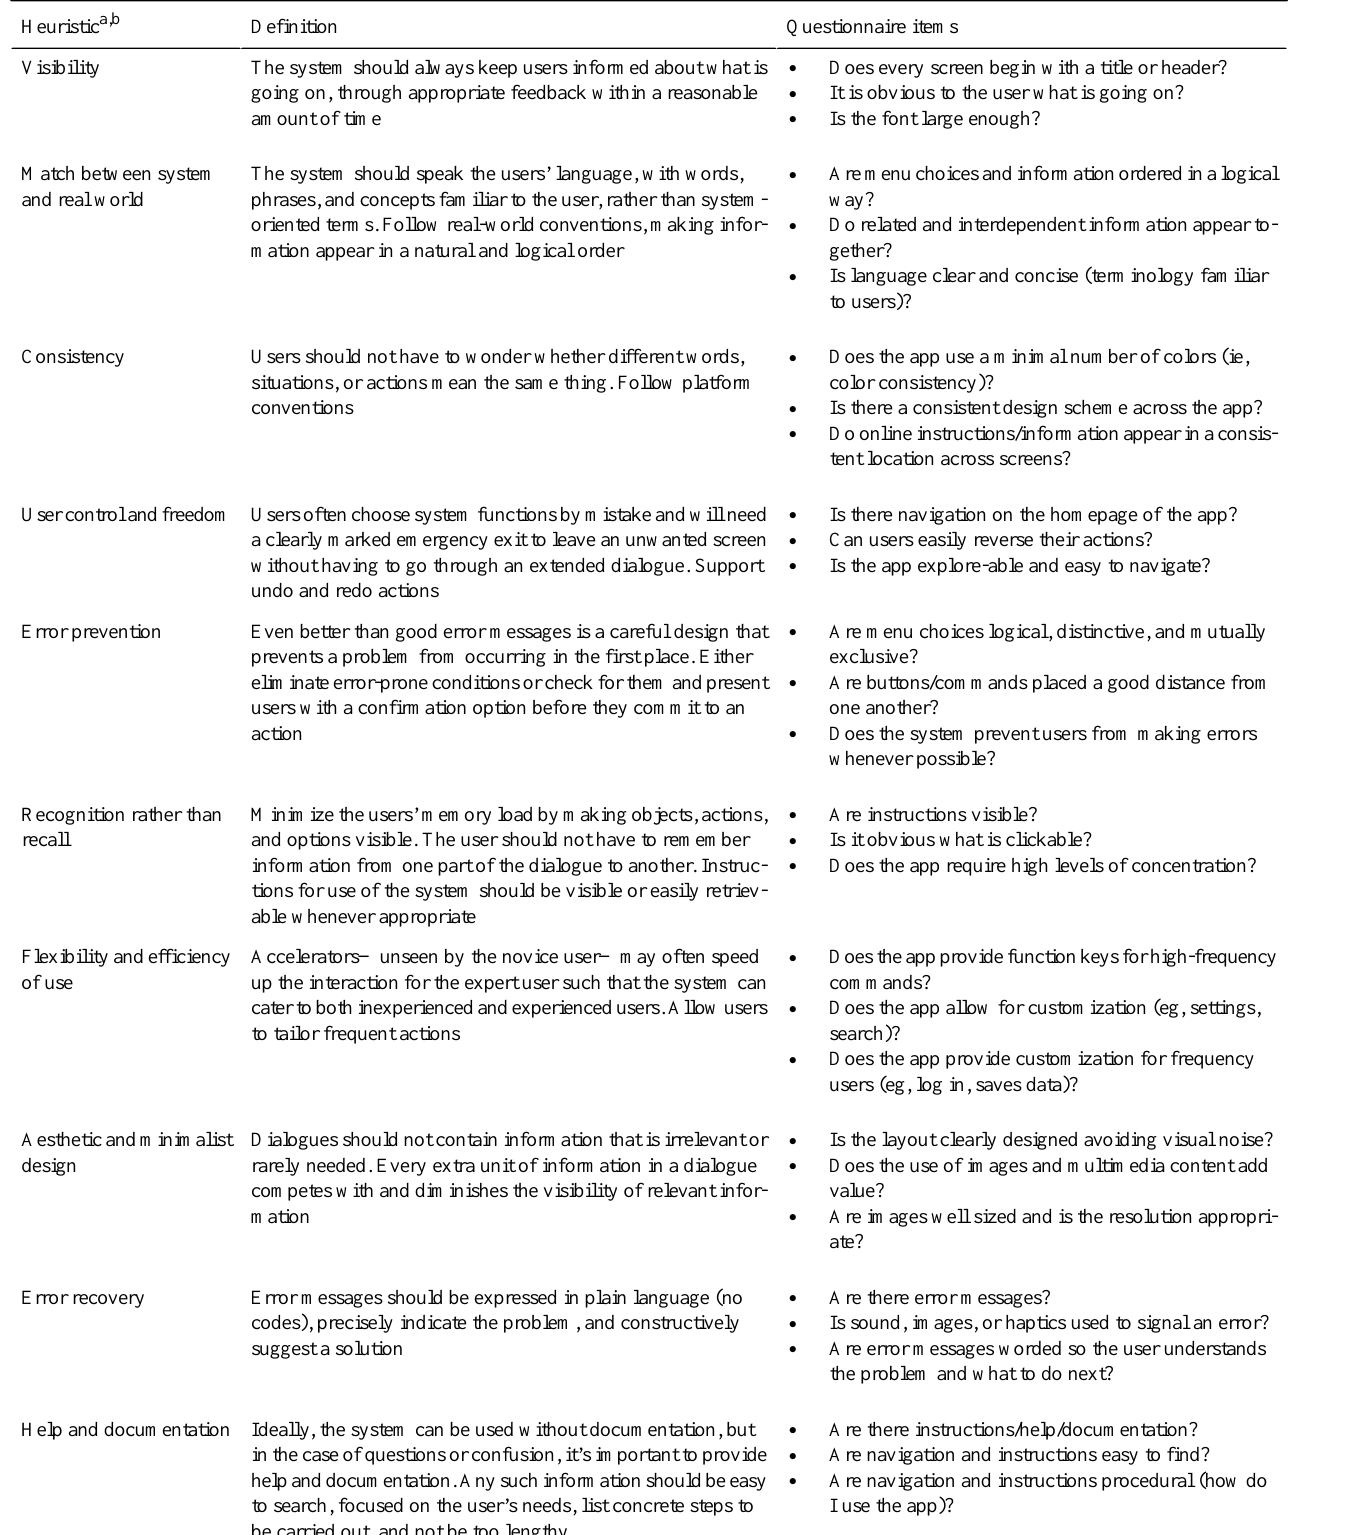
Table 1. Usability heuristics for user interface